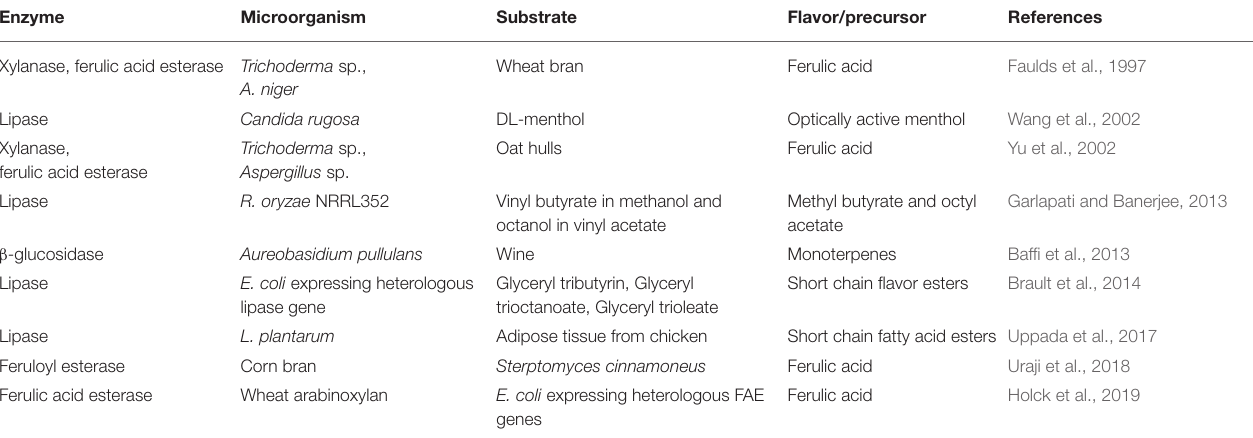
TABLE 2 | Microbial enzymes in flavor production.